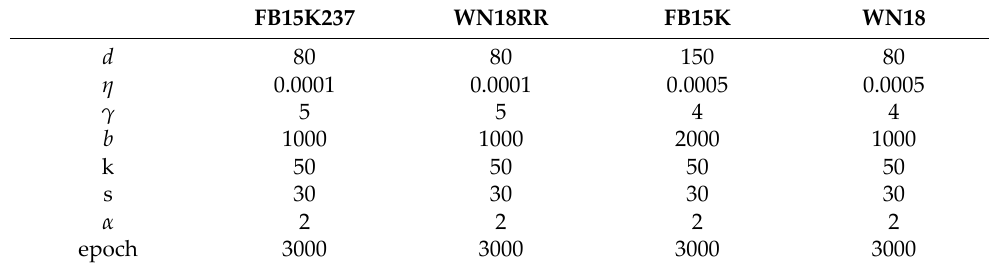
Table 3. Optimal configurations of each